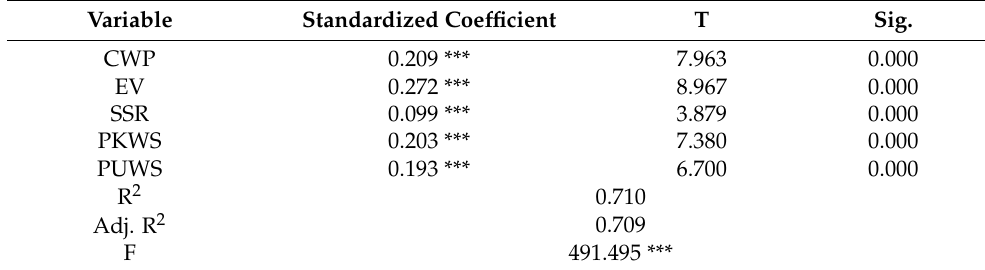
Table 3. Regression analysis results of the effects of waste separation awareness on